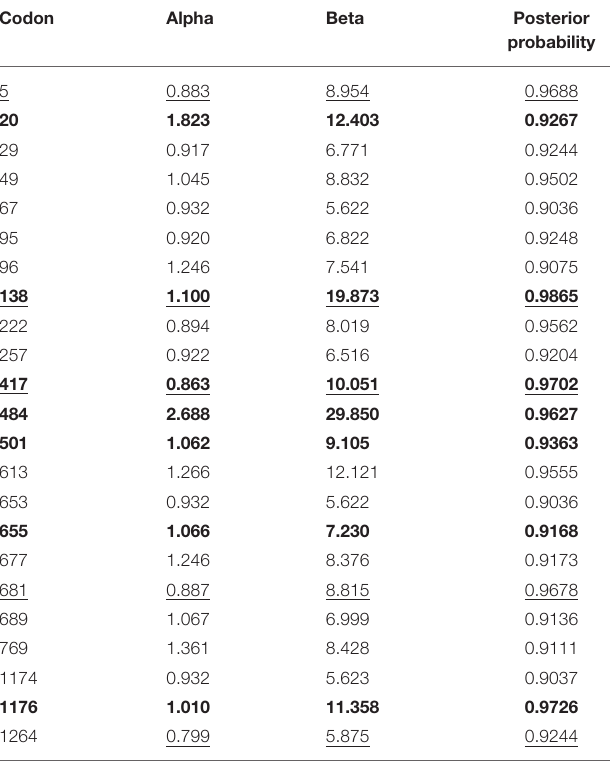
TABLE 4 | Fast Unbiased AppRoximate Bayesian (FUBAR) analysis of pervasive diversifying selection on spike protein. Codon Alpha Beta Posterior